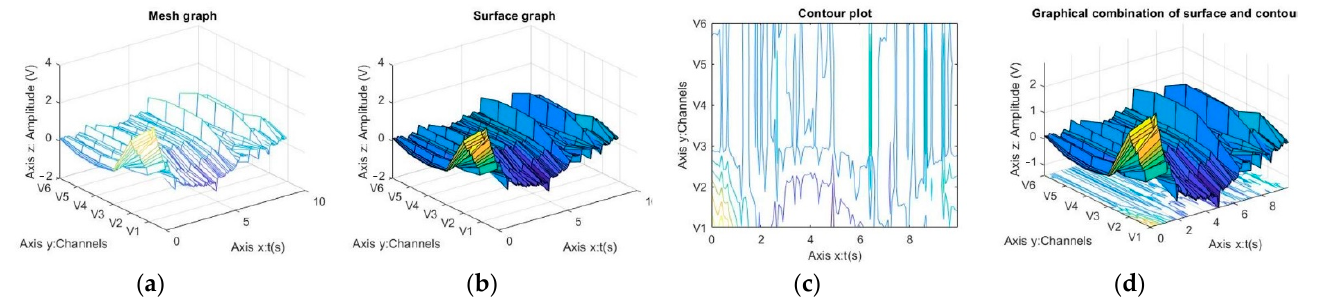
Figure 5. Three-dimensional plots in MATLAB corresponding to Patient 5803: ( a ) Mesh surface used to give effect to a two-dimensional x×y matrix. ( b ) The surface plot creates a colored three-dimensional surface instead of a mesh. Here, from the top shows the sECG. Over time, the composition of the six channels provides a three-dimensional image that is also an sECG distinguished by its colors. ( c ) Contour plot that represents two-dimensional and three-dimensional surfaces. ( d ) Combination of the contour plot with a surface.